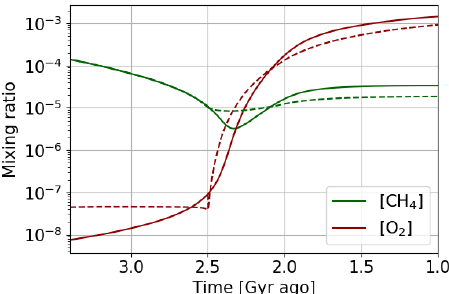
Figure 17. Temporal evolution of oxygen and methane with α i = 1. Oxygen atmospheric loss ( F O ) Goldblatt et al. (2006) parameteri- 2 zation (solid) and GCM 1D results (dashed).